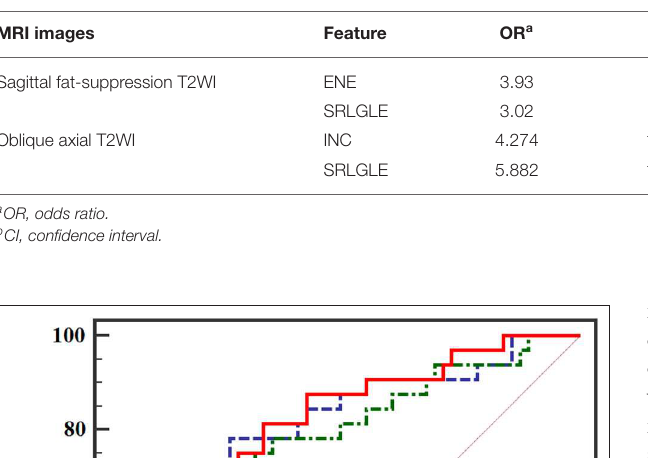
that patients in a negative regional lymph node metastasis group had significant higher skewness, kurtosis and energy, and lower entropy of tumors on T2WI than in a positive